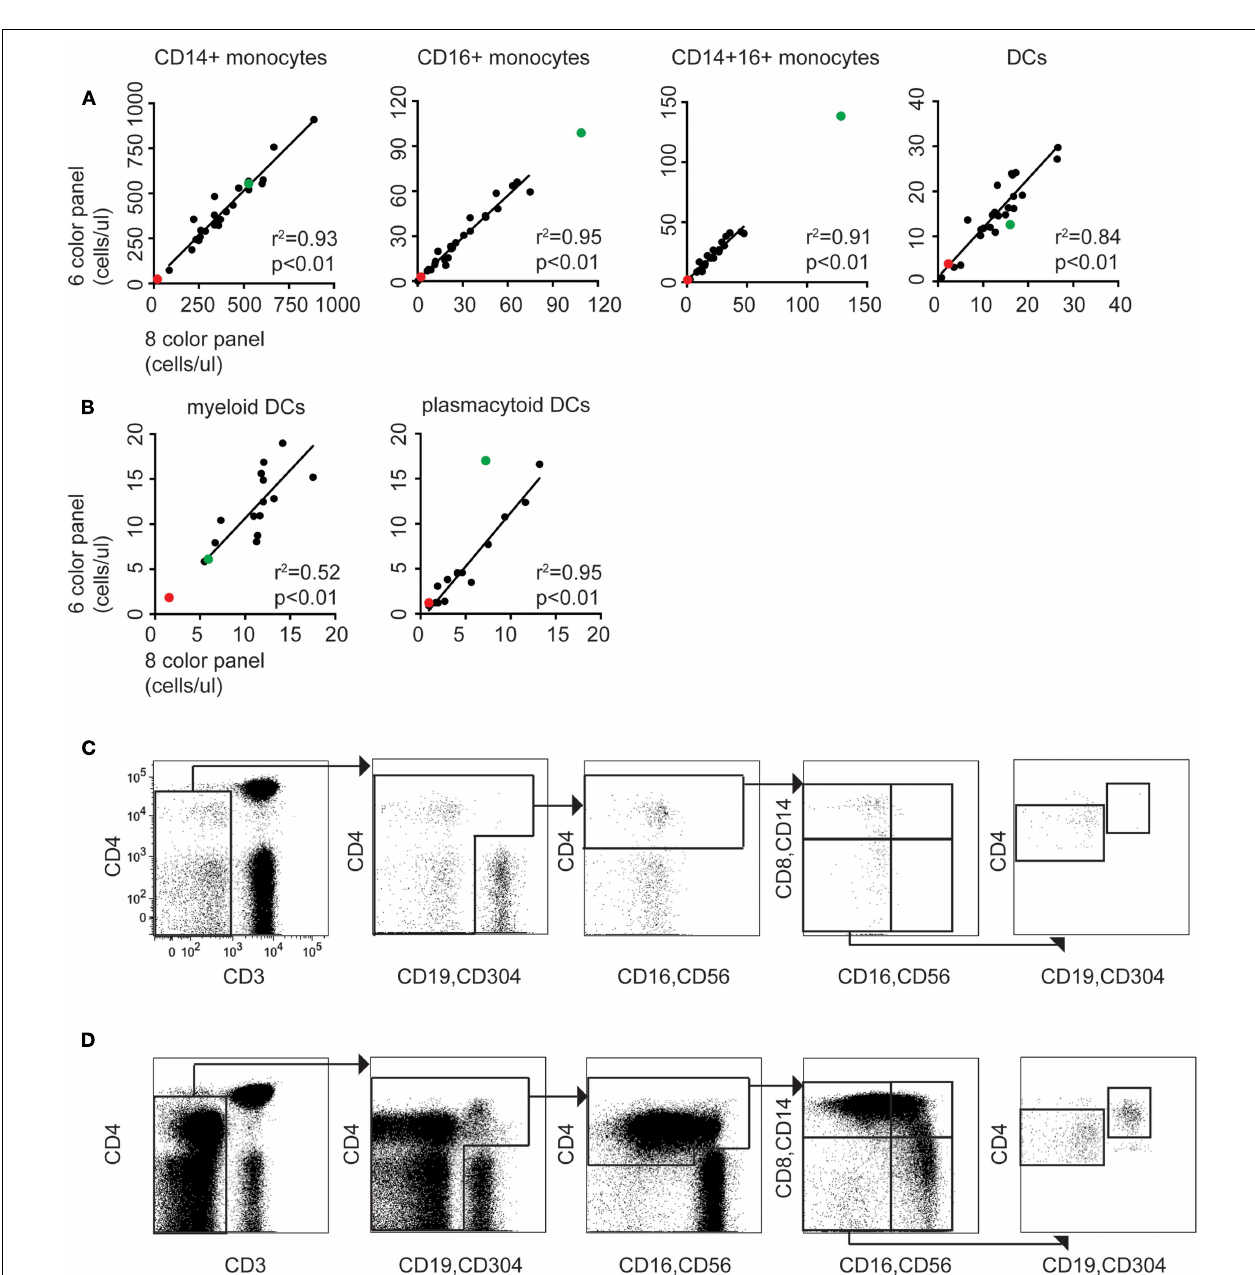
using the 6-color panel modified with CD14 and CD304 vs. the standard 8-color DC panel ( n = 14). (C) The modifiedTBNK assay applied to case 1 (DCML deficiency). Note the scarcity of CD3 − cells relative to CD3 + T cells. This arises from reduction in B cells, absence of NK cells, and virtual absence of all monocyte and DC subsets.The small population of CD3 − CD4 bright cells gated out in the initial plot are activatedT cells with reduced CD3 expression. (D) The modifiedTBNK assay applied to case 2